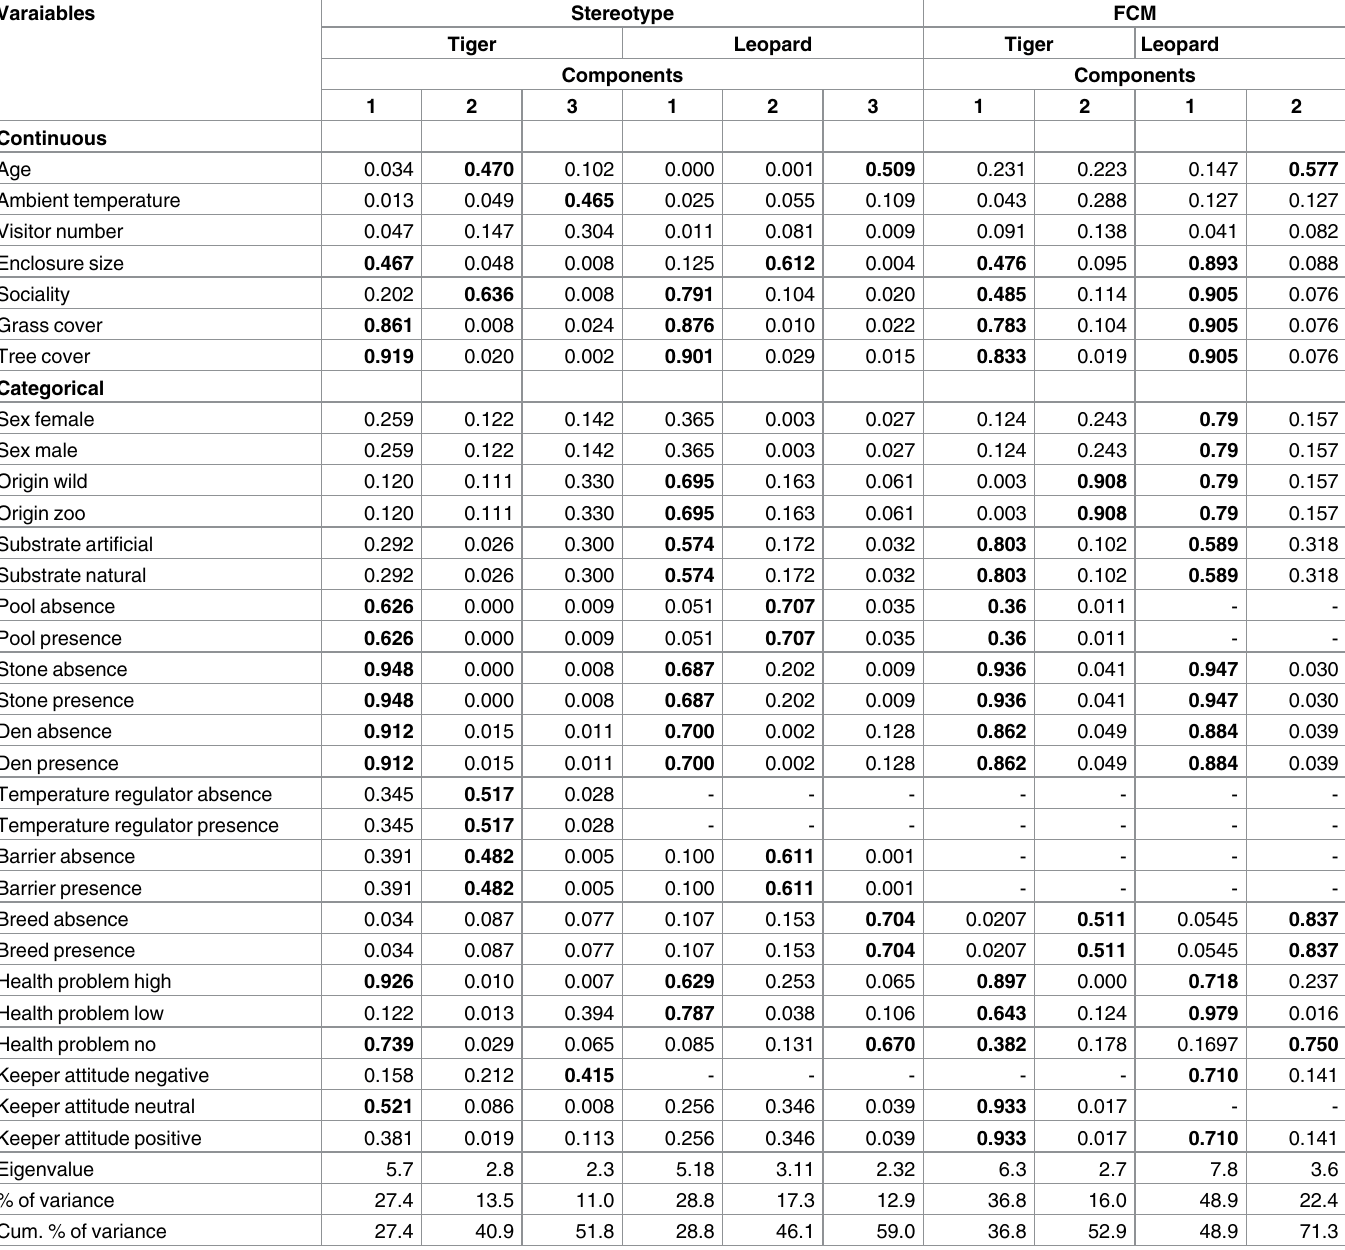
Table 6. Influence of variables (COS 2 ) on different components obtained from Factor Analysis of Mixed Data (FAMD) by FactoMineR to evaluate the effectsof biological and environmental variables on stereotype and FCM of tigers and leopards in captivity.